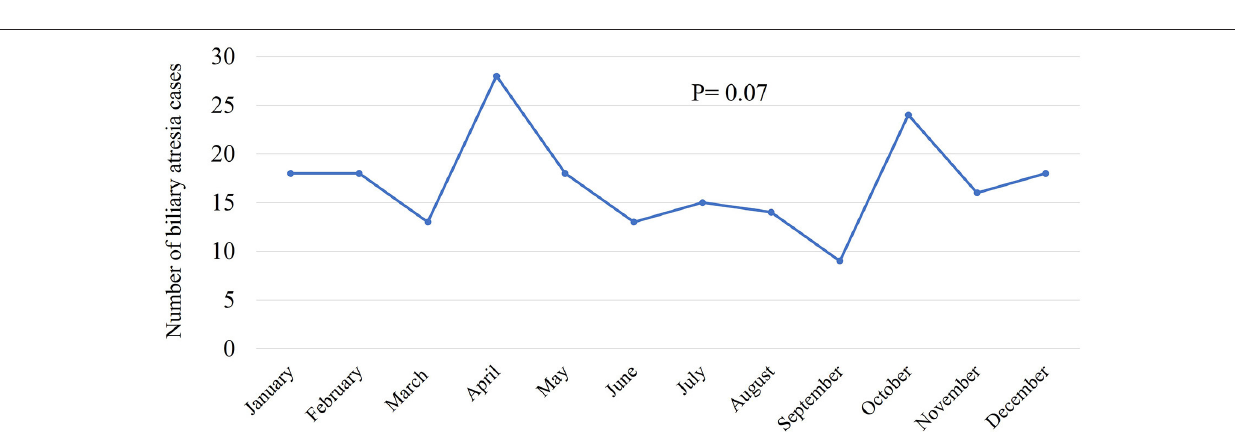
FIGURE 2 | Incidence of biliary atresia cases per